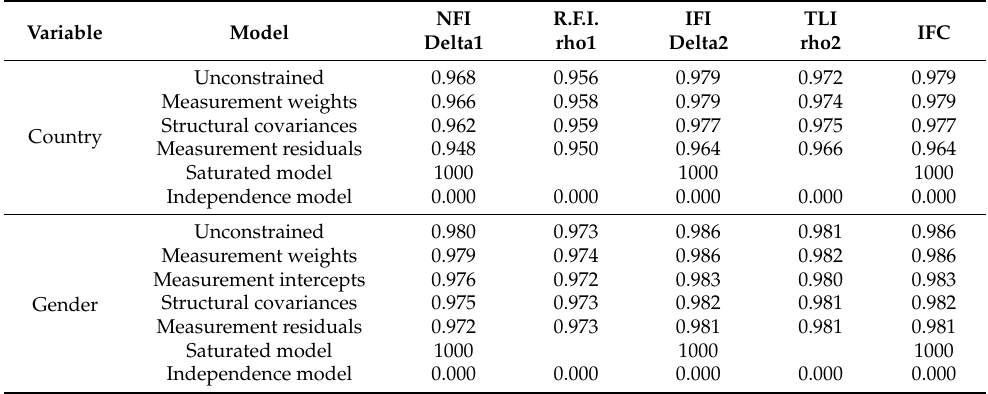
Table 11. Metric